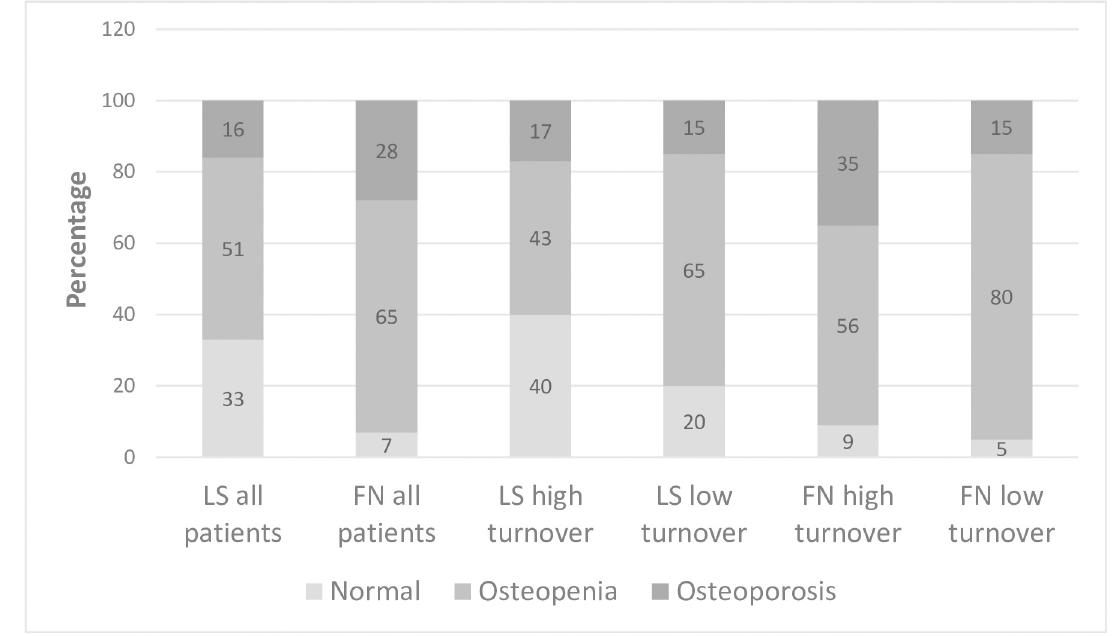
Fig 3. The prevalence of osteopenia and osteoporosis at the lumbar spine and femoral neck in DXA scan.